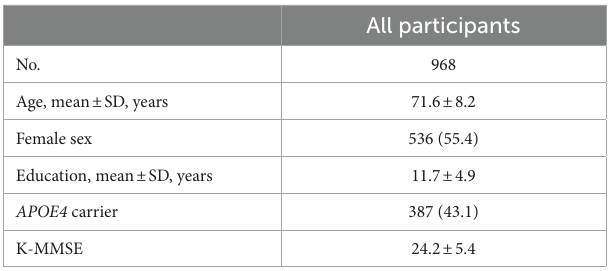
TABLE 1 Demographics of the study participants (total).